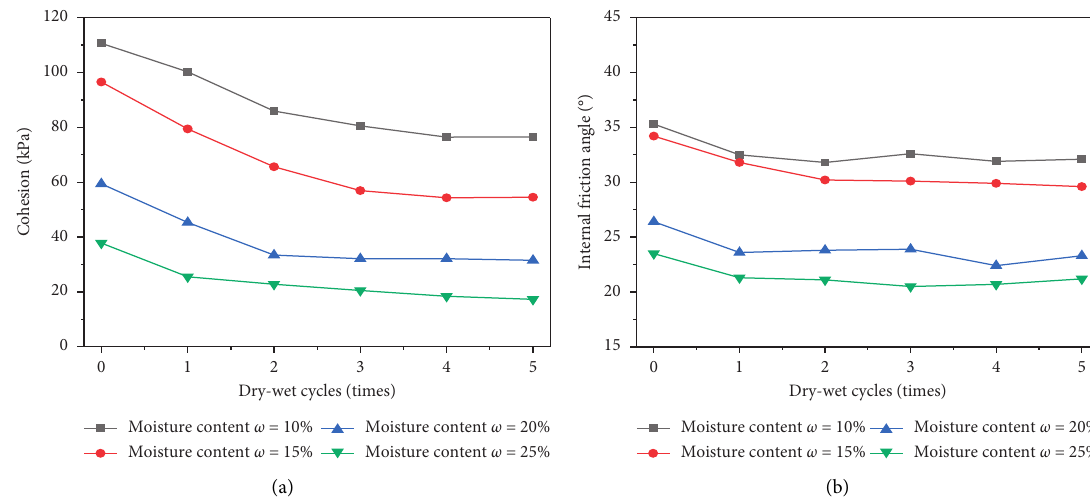
Figure 12: Relationship between the strength parameters of the soil samples with different moisture contents and numbers of cycles in Luochuan. (a) Relationship between cohesion ( c ) and number of cycles ( N ). (b) Relationship between friction angle ( φ ) and number of cycles ( N ).